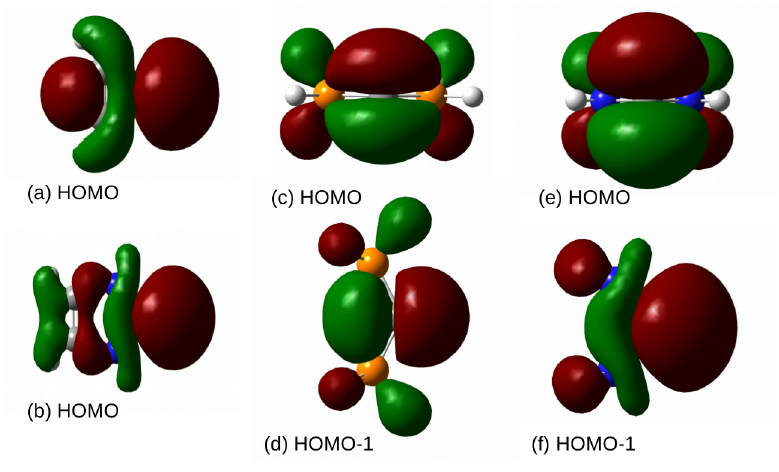
Figure 6. Molecular orbitals of carbenes and CDPs: ( a ) HOMO of cyclopropenylidene, ( b ) HOMO of imidazol-2-ylidene, ( c ) HOMO of (PH 3 ) 2 C, ( d ) HOMO-1 of (PH 3 ) 2 C, ( e ) HOMO of (NH 3 ) 2 C, ( f ) HOMO-1 of (NH 3 ) 2